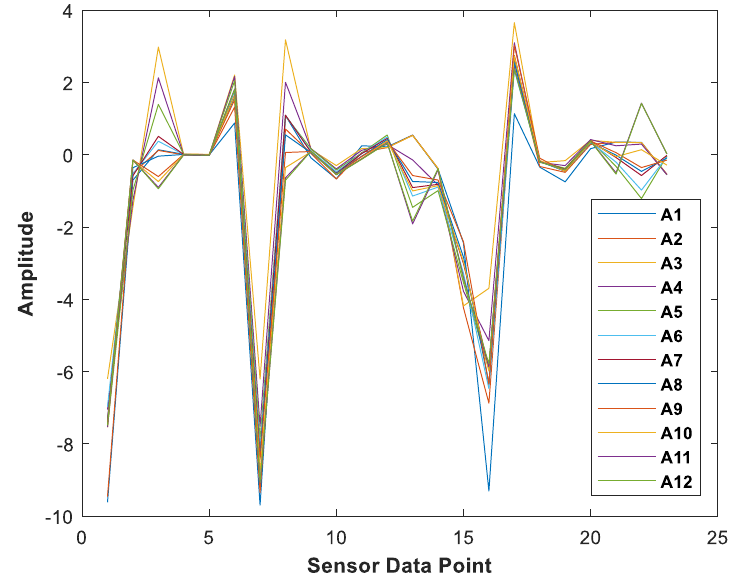
Figure 4. Mean of the 23 raw data point (i.e., L ) from twelve different activities.